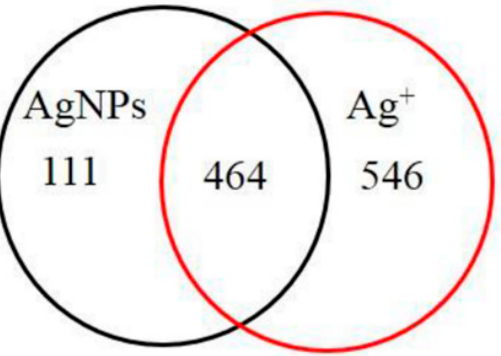
Figure 11. Venn diagrams of genes with more than two-fold expression changes and shared among the six stresses between Ag NPs and Ag + . Reprinted with permission from Ref. [24].